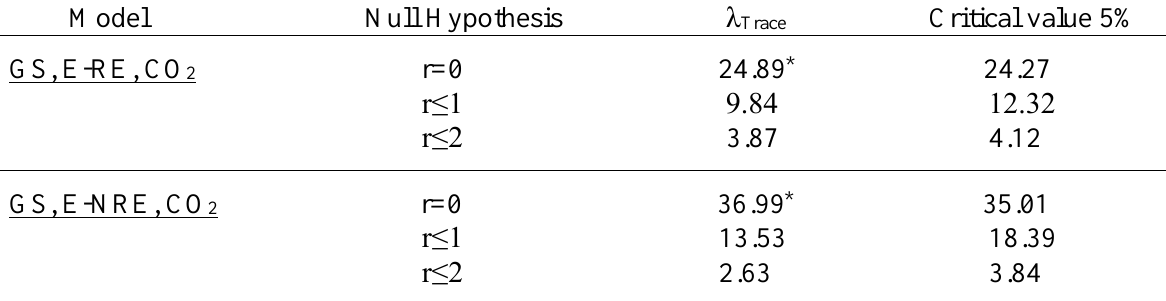
Table 2. Results of cointegration